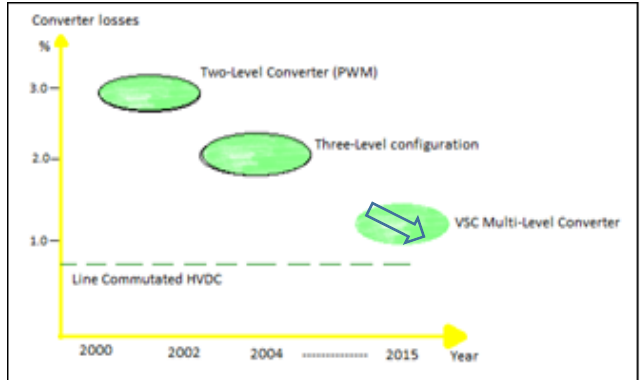
Fig. 10. Monopolar HVDC model.